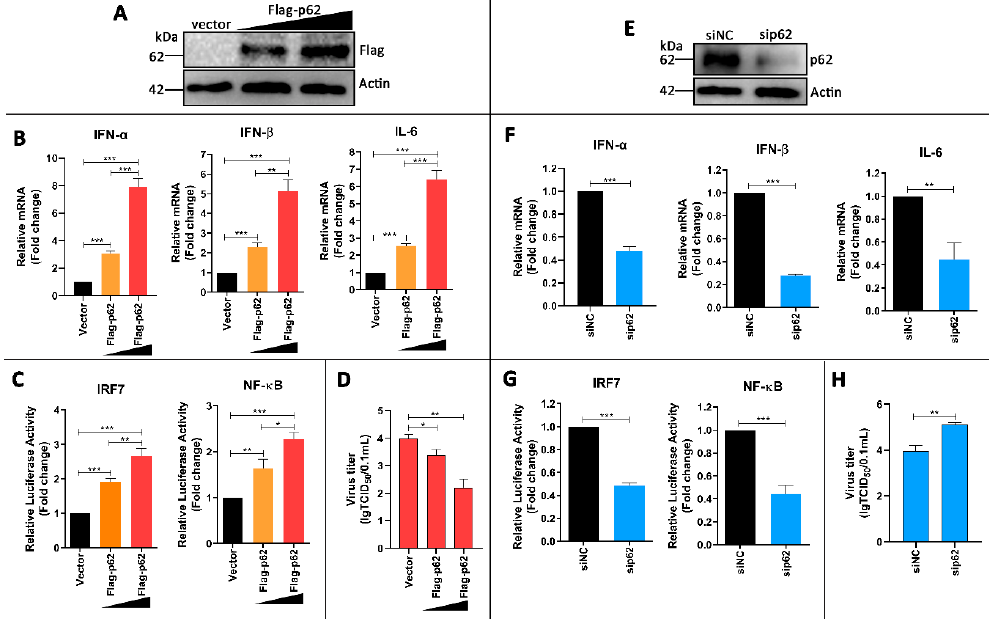
Figure 6. E ff ect of p62 on innate immune responses and DTMUV replication in DTMUV-infected cells. ( A ) DEF cells were transfected with vector, Flag-p62 (1 µ g), or Flag-p62 (2 µ g) plasmids for 24 h prior to infection and then infected with DTMUV at an MOI of 1 for 24 hpi. Cells were harvested for Western blot analysis and immunoblotted for Flag and β -actin. ( B ) Parallel samples from ( A ) were performed for the mRNA levels of IFN- α , IFN- β , and IL-6 by qPCR. The mRNA levels of targeting genes to β -actin were normalized to control. ( C ) DEF cells were co-transfected with 0.1 µ g of NF- κ B–luc or IRF7-luc and with 0.01 µ g of pRL-TK plasmid, along with vector, Flag-p62 (1 µ g) or Flag-p62 (2 µ g) plasmids for 24 h prior to infection. Cells were infected with DTMUV at an MOI of 1 for 36 h and then preformed for luciferase reporter assays. The luciferase activities of targeting promoters were normalized to control. ( D ) Progeny virus yields in parallel samples from ( A ) were determined by TCID50 assay. ( E ) DEF cells were transfected with siNC or sip62 for 24 h prior to infection and then infected with DTMUV at an MOI of 1 for 24 h. Cells were harvested for Western blot analysis and immunoblotted for p62 and β -actin. ( F ) Parallel samples from ( E ) were performed for the mRNA levels of IFN- α , IFN- β , and IL-6 by qPCR. The mRNA levels of targeting genes to β -actin were normalized to control. ( G ) DEF cells were co-transfected with 0.1 µ g of NF- κ B–luc or IRF7-luc and with 0.01 µ g of pRL-TK plasmid, along with siNC or sip62 for 24 h prior to infection. Cells were infected with DTMUV at an MOI of 1 for 24 hpi and then preformed for luciferase reporter assays. The luciferase activities of targeting promoters were normalized to control. ( H ) Progeny virus yields in parallel samples from ( E ) were determined by TCID50 assay. Error bars: Mean ± SD of three independent experiments. Two-tailed Student’s t